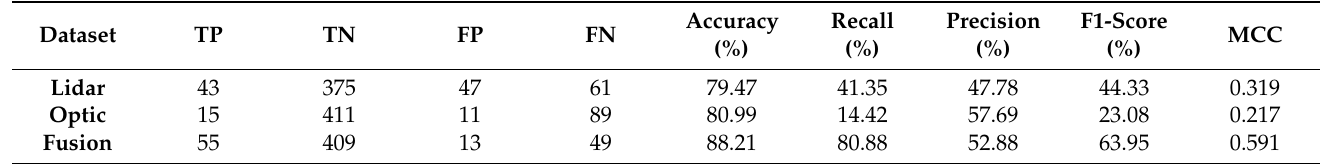
Table 7. The numerical result from BDD-Net for the Test Area.